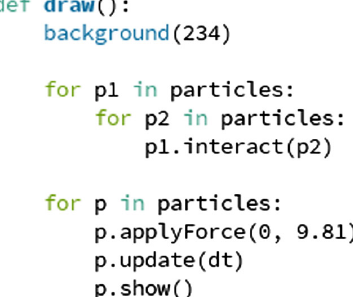
Schatz,FIG. 7. The loop that is iterated over each timestep of the simulation. The particles all interact with each other and then they update their position and show themselves in the window. draw() is called as fast as possible, or as fast as the display allows, which is usually around 60 times per